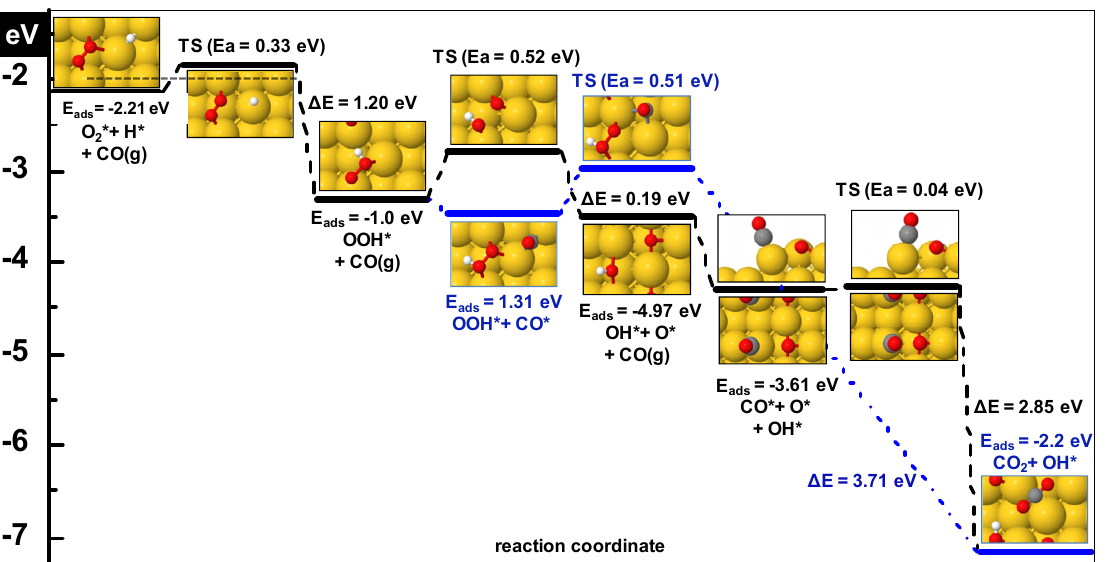
formation in the presence of H on Au(310). After OOH Figure 3. Reaction profile for CO 2 formation, two paths have been explored: a) decomposition of OOH into O and OH where and b) via direct reaction of CO the formed O subsequently reacts with CO to form CO 2 with OOH. Activation energy and reaction energy are indicated for each elementary step. , H and the clean slab. The horizontal dashed Zero level corresponds to gas phase CO, O 2 line indicates the desorption level of O 2